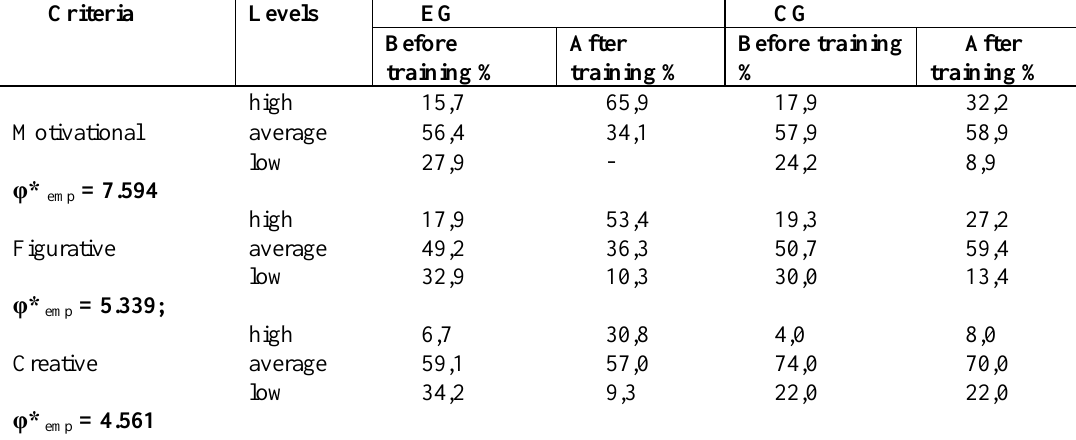
Table 1. Levels of aesthetic education of bachelors by means of information technologies